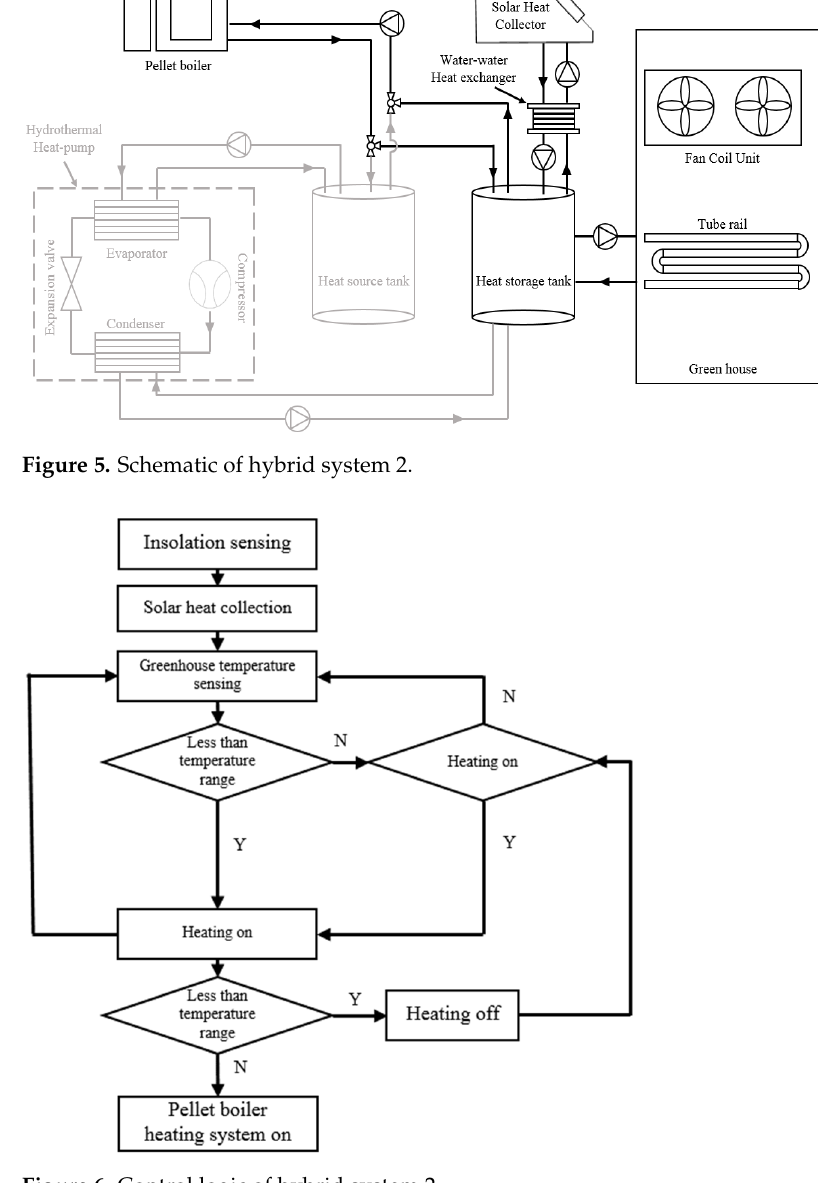
Figure 6. Control logic of hybrid system 2.